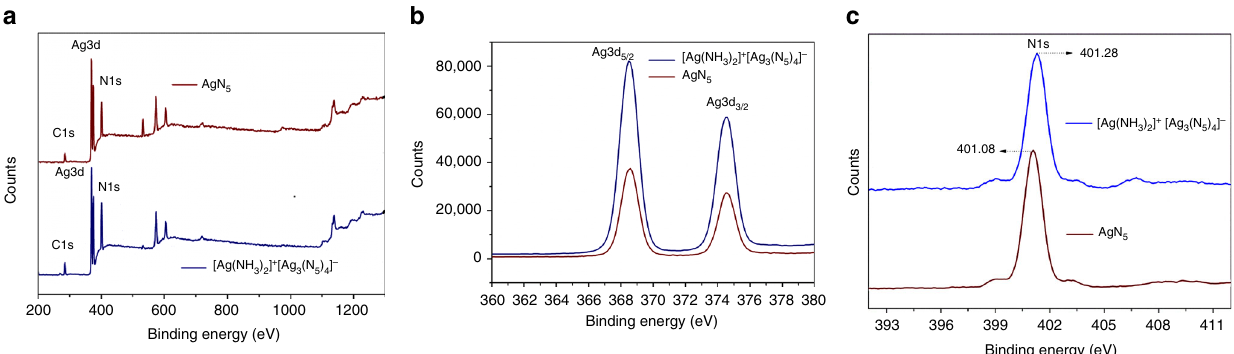
Fig. 4 XPS spectra. a The wide scan spectra of [Ag(NH 3 ) 2 ] + [Ag 3 (N 5 ) 4 ] ˉ and the AgN 5 complex. b Core-level Ag3d XPS spectrum. c Core-level N1s XPS spectrum